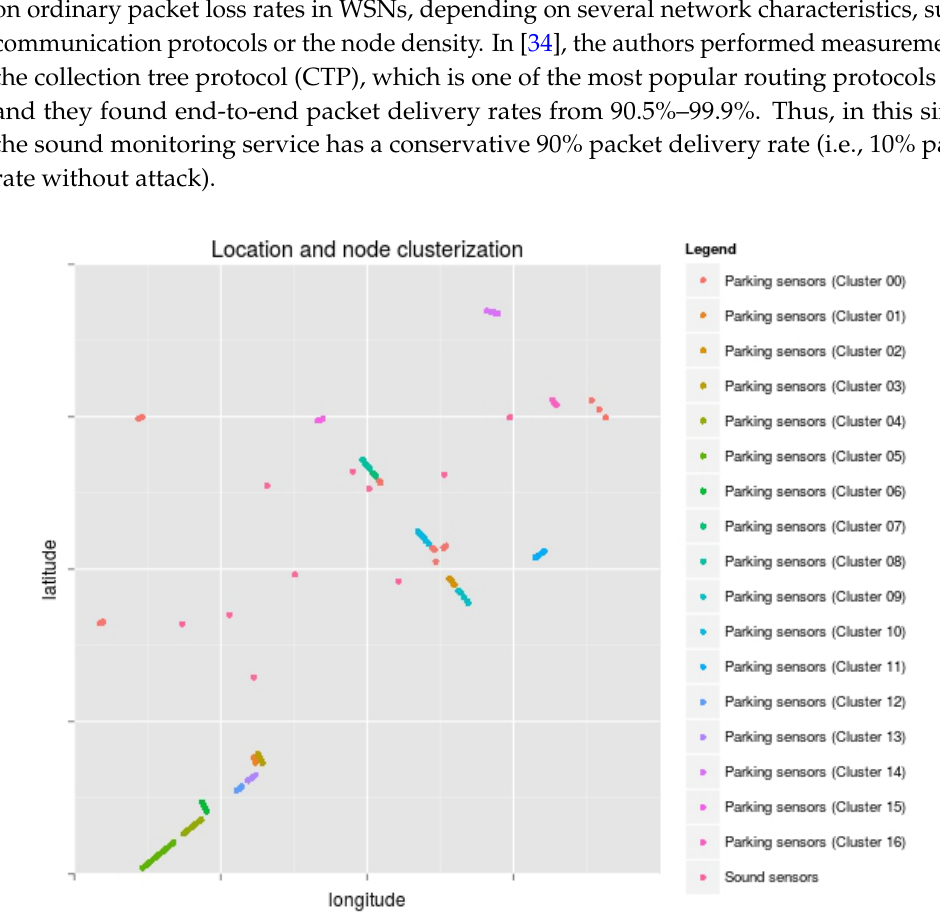
Figure 6. Sensor positions and division of the parking sensor nodes in